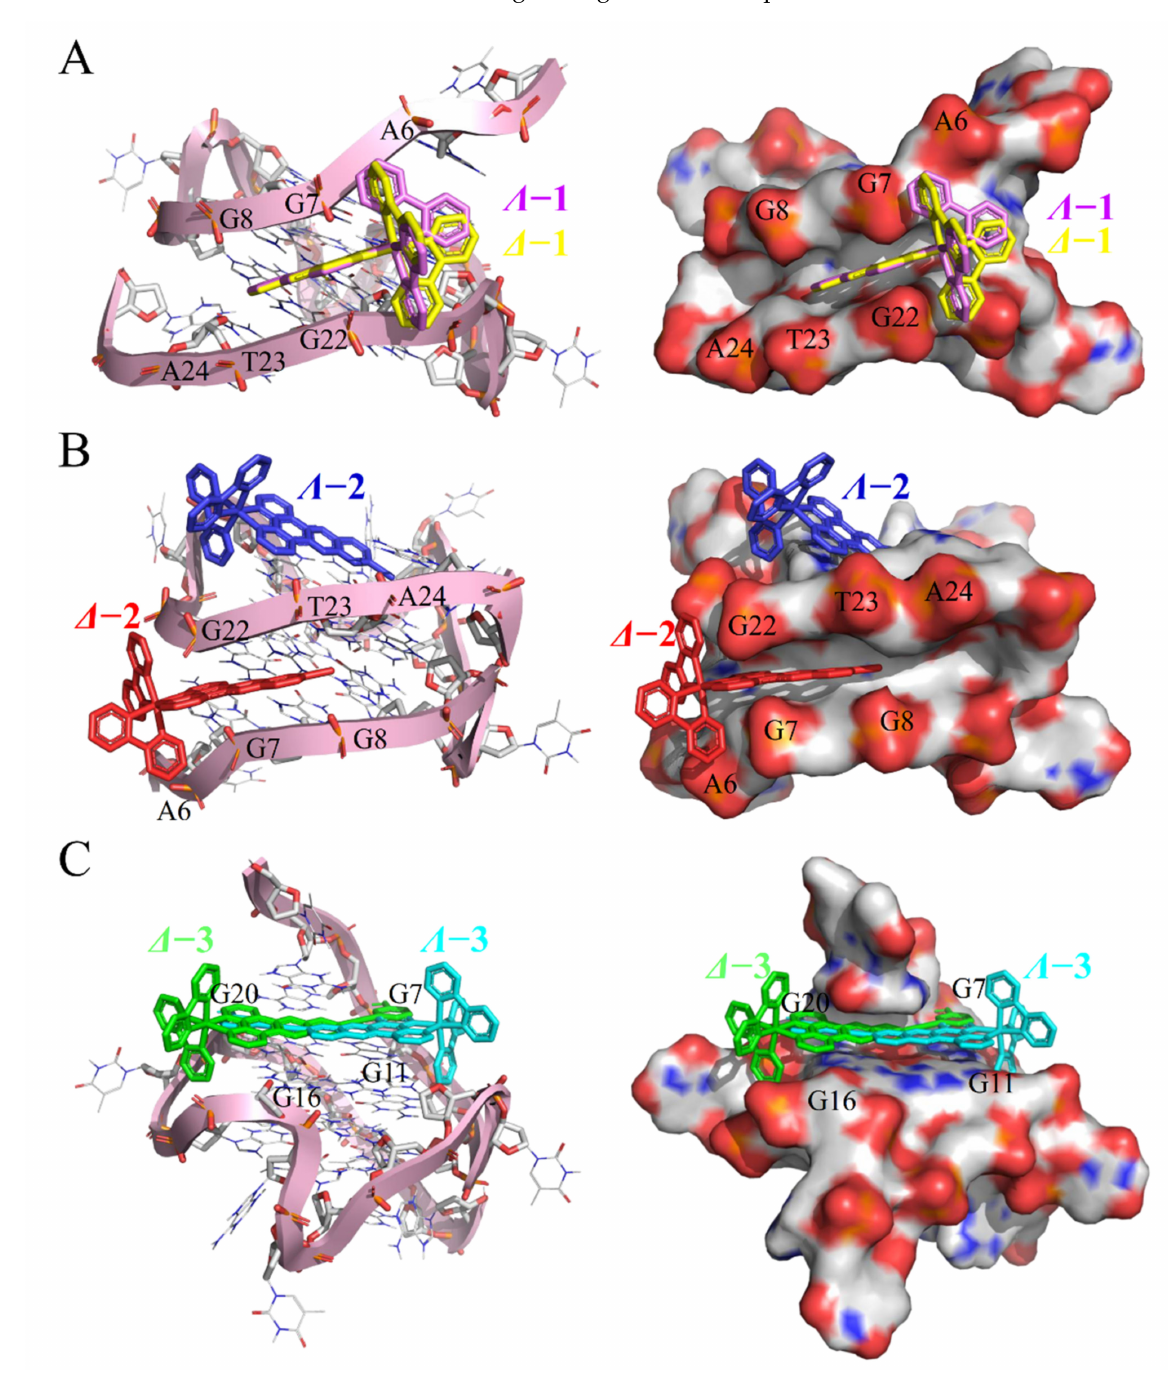
Figure 2. The interaction between chiral DPPZ-based Ru(II)complexes with c-myc G-quadruplex DNA. The binding site and binding mode of ( A ) Λ − 1 (purple) and ∆ − 1 (yellow); ( B ) of Λ − 2 (blue) and ∆ − 2 (red); and ( C ) of Λ − 3 (cyan) and ∆ − 3 (green) with c-myc G-quadruplex DNA calculated by molecular